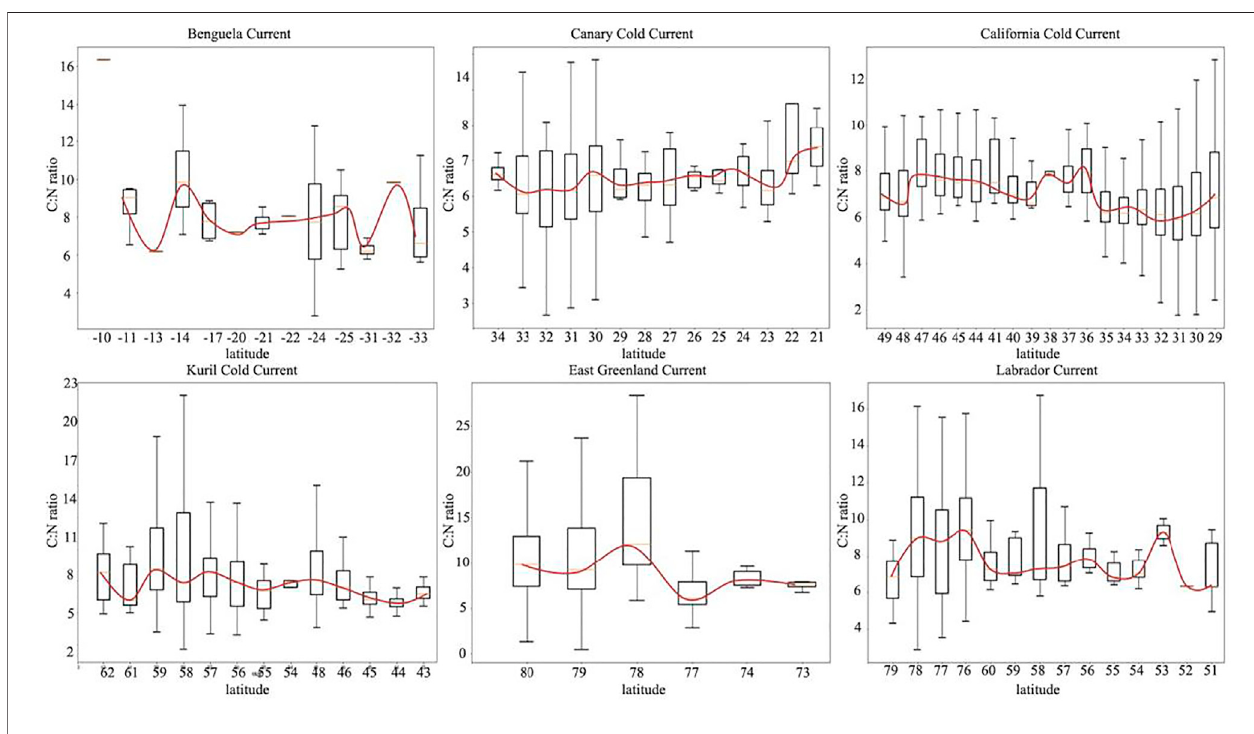
FIGURE 5 | POC-to-PON ratio variation along cold currents.